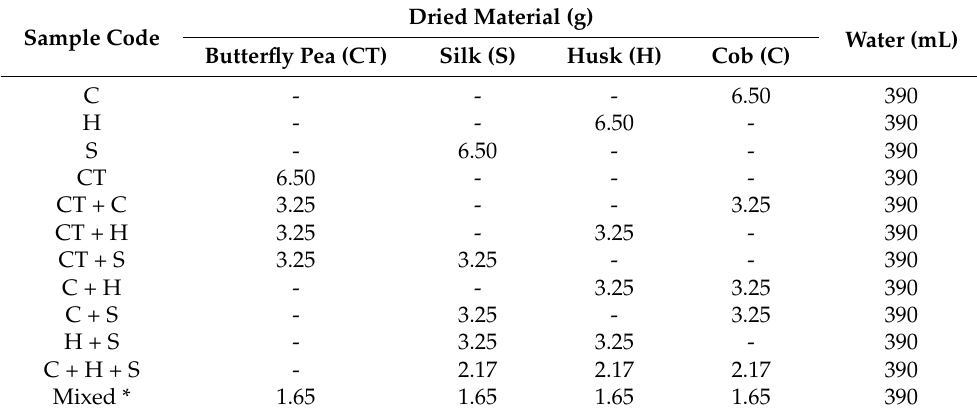
Table 5. Composition of each extraction sample and its extraction yield.